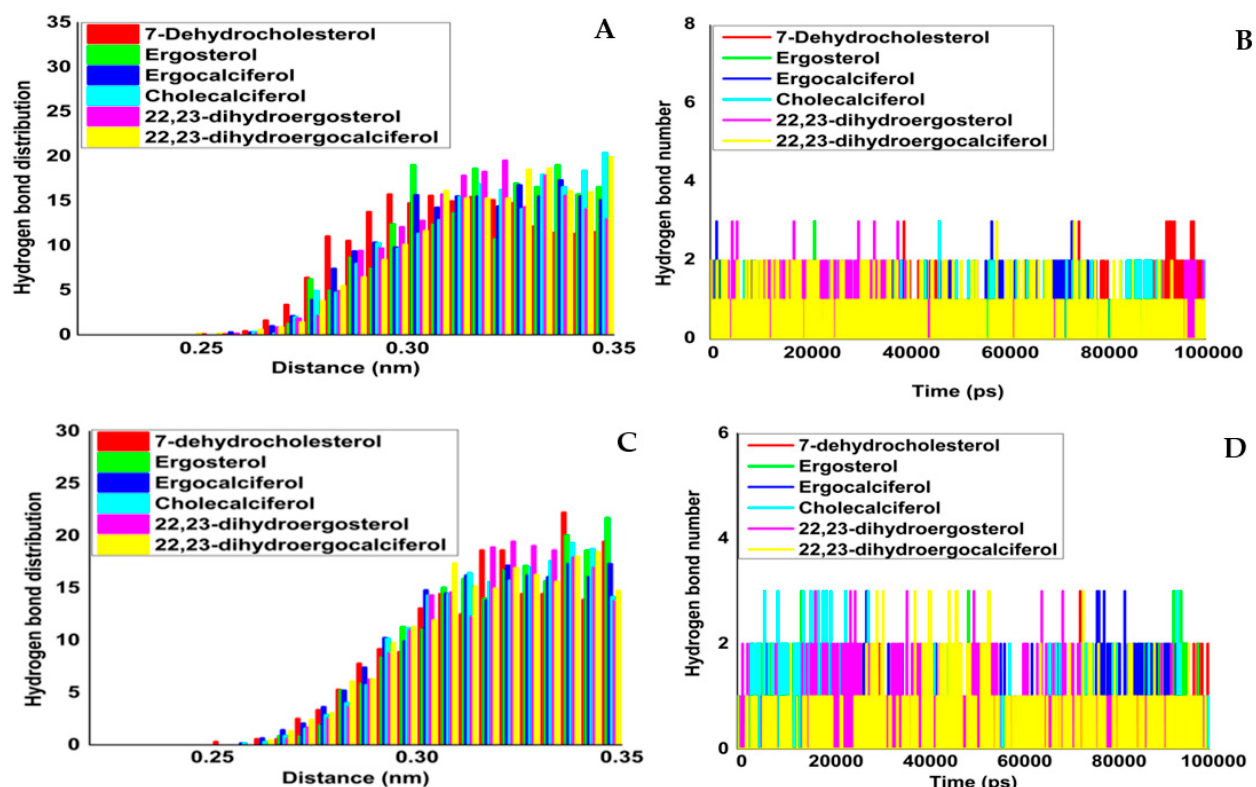
Figure 5. Hydrogen bond formation during the 100 ns simulation and hydrogen bond distribution between protease and ligand between Mpro and ligand molecules. ( A ) Hydrogen bond distribution; ( B ) no. of hydrogen bonds, PLpro and ligand molecules; ( C ) hydrogen bond distribution, and ( D ) no. of hydrogen